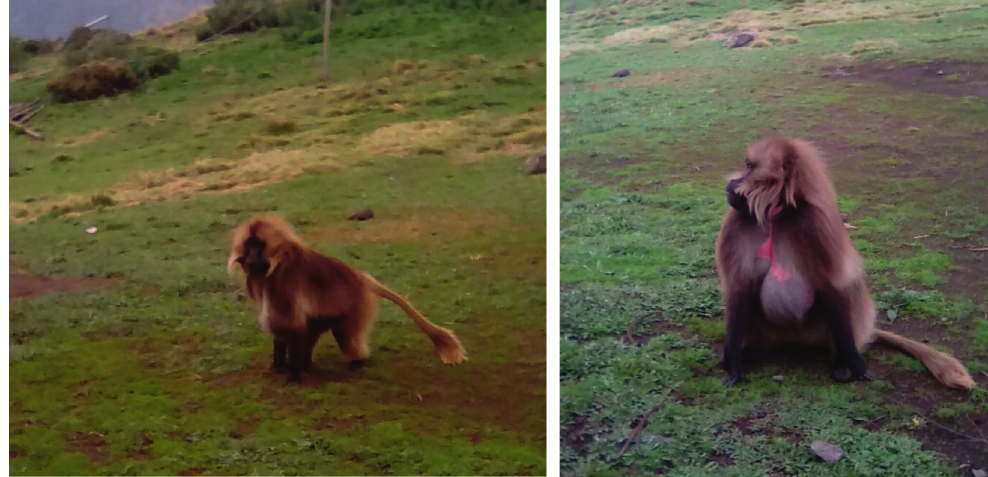
Figure 5: Geladas, photos captured at Semien Mountains National Park by the